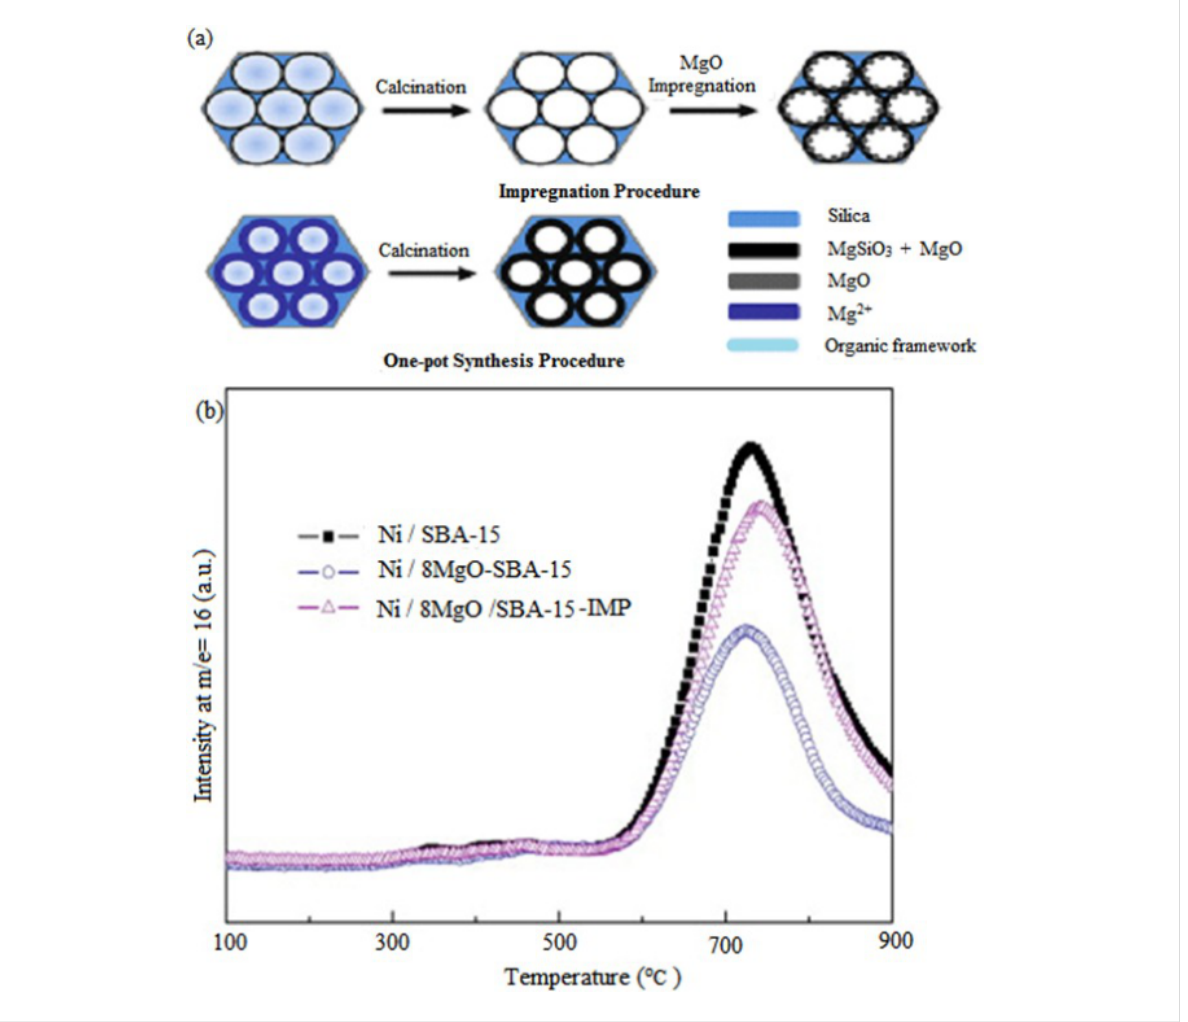
Figure 9: (a) Schematic illustration of the two synthesis methods for the MgO basic sites formation on SBA-15, (b) TPH profiles of spent catalysts after 40 h stability test. Reprinted with permission from [119], copyright 2013 Elsevier.